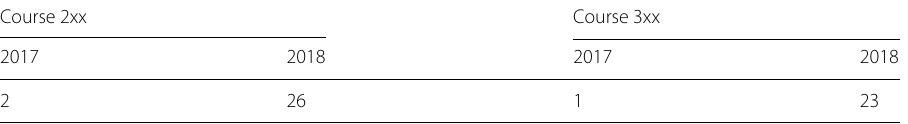
Table 3 Class forum discussion threads about tests in the two courses after the (first) test –